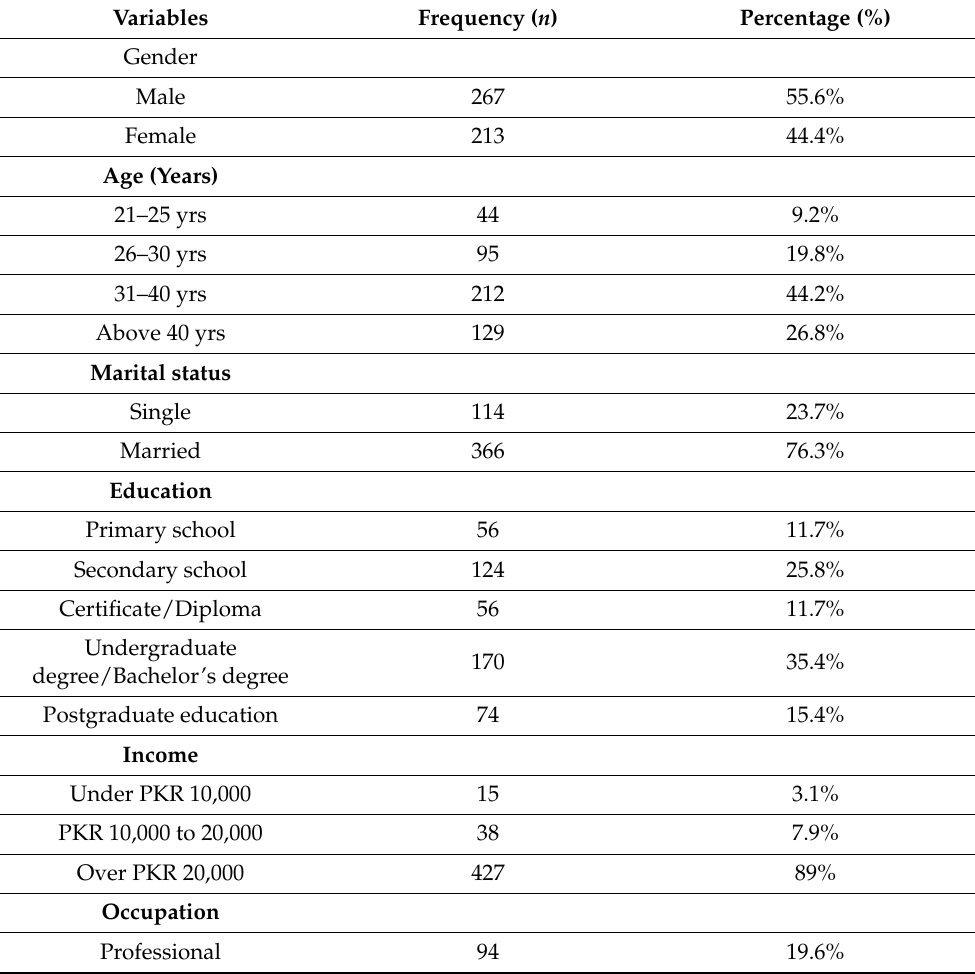
Table 1. Sociodemographic characteristics of the participants included in the